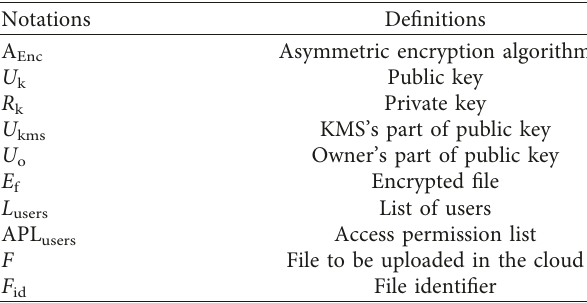
Figure 2: Encryption process by CKMS. Table 1: Notations and definitions.